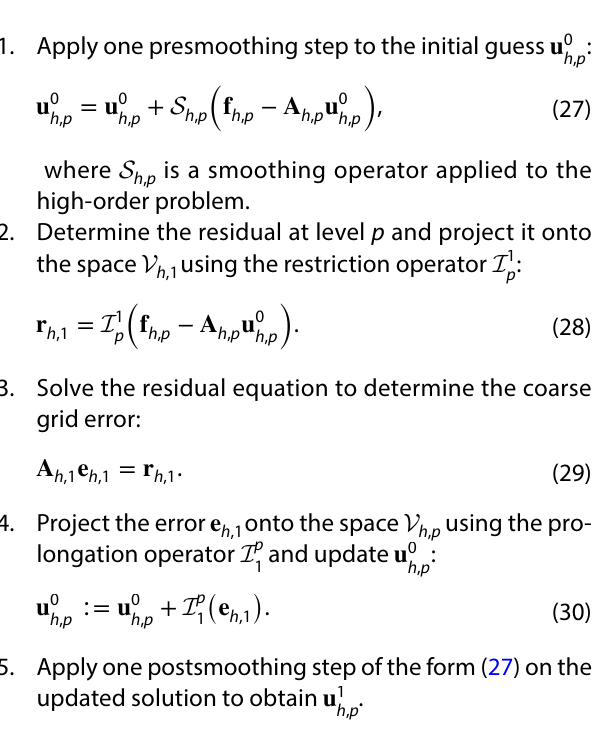
Fig. 4 Illustration of the p -multigrid method [13]. At p = 1 , Gauss–Seidel is adopted as a smoother (filled circle), whereas at the high-order level ILUT is applied (filled triangle). At the coarsest level, a direct solver is applied to solve the residual equation (filled